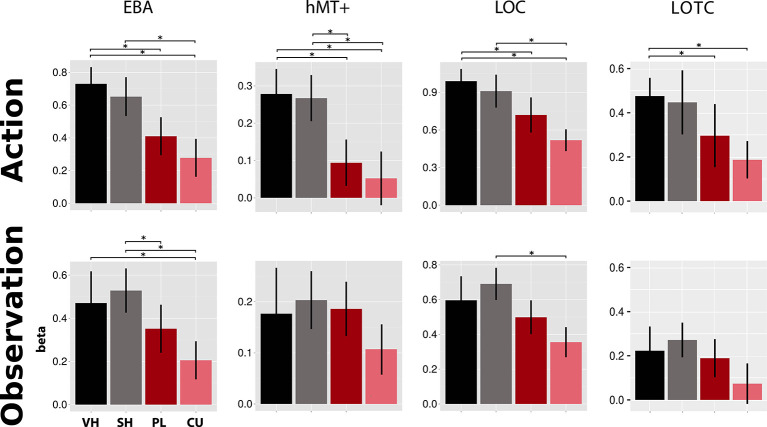
Activations in four literature-driven (EBA, hMT+, LOC, and LOTC, see Table 1) left-hemispheric ROIs. Beta value means and standard errors extracted for VH (black), SH (gray), PL (dark red), and CU (light red) conditions during both action (top) and observation (bottom). Asterisks indicate significant changes between conditions (p < 0.05). Abbreviations: EBA, extrastriate body area; hMT+, human area MT+; LOC, lateral occipital complex; LOTC, lateral occipitotemporal complex. This figure indicates that during the action and observation realistic displays of a human hand (SH and VH) activate the literature-driven ROIs more strongly than point-light (PL) or cursor (CU) displays.